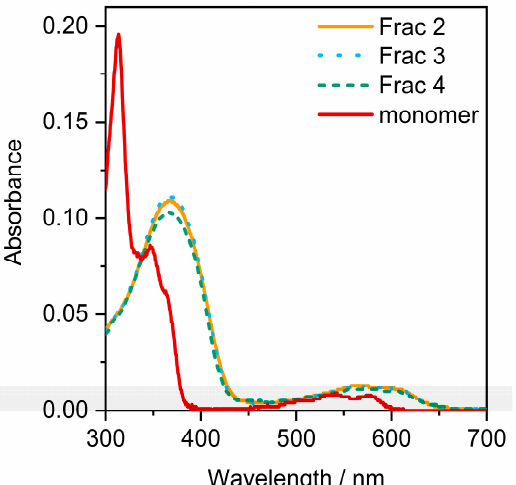
Figure 3. UV-vis absorption spectra of monomer and Fractions 2–4 in the chloroform (1.0 × 10 − 5 M per repeating units).